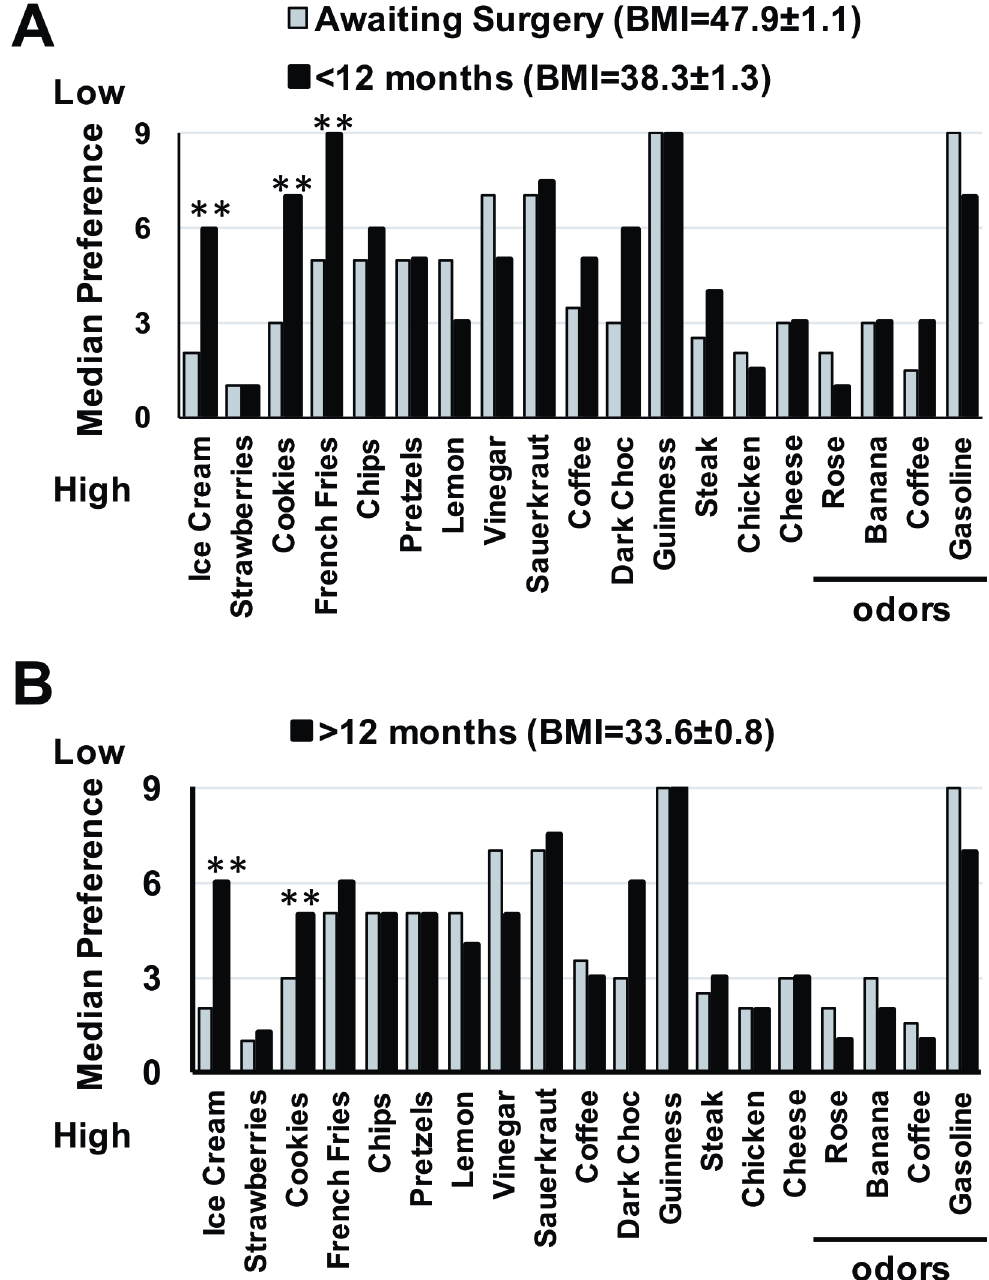
Fig 4. Median preference ratings for all pictures representing taste and odor stimuli for those awaiting RYGB surgery and those who have had RYGB surgery. A. Subjects who had RYGB surgery less than 12 months prior to the survey. B. Subjects who had RYGB surgery more than 12 months prior to the survey. (cid:3)(cid:3) p <